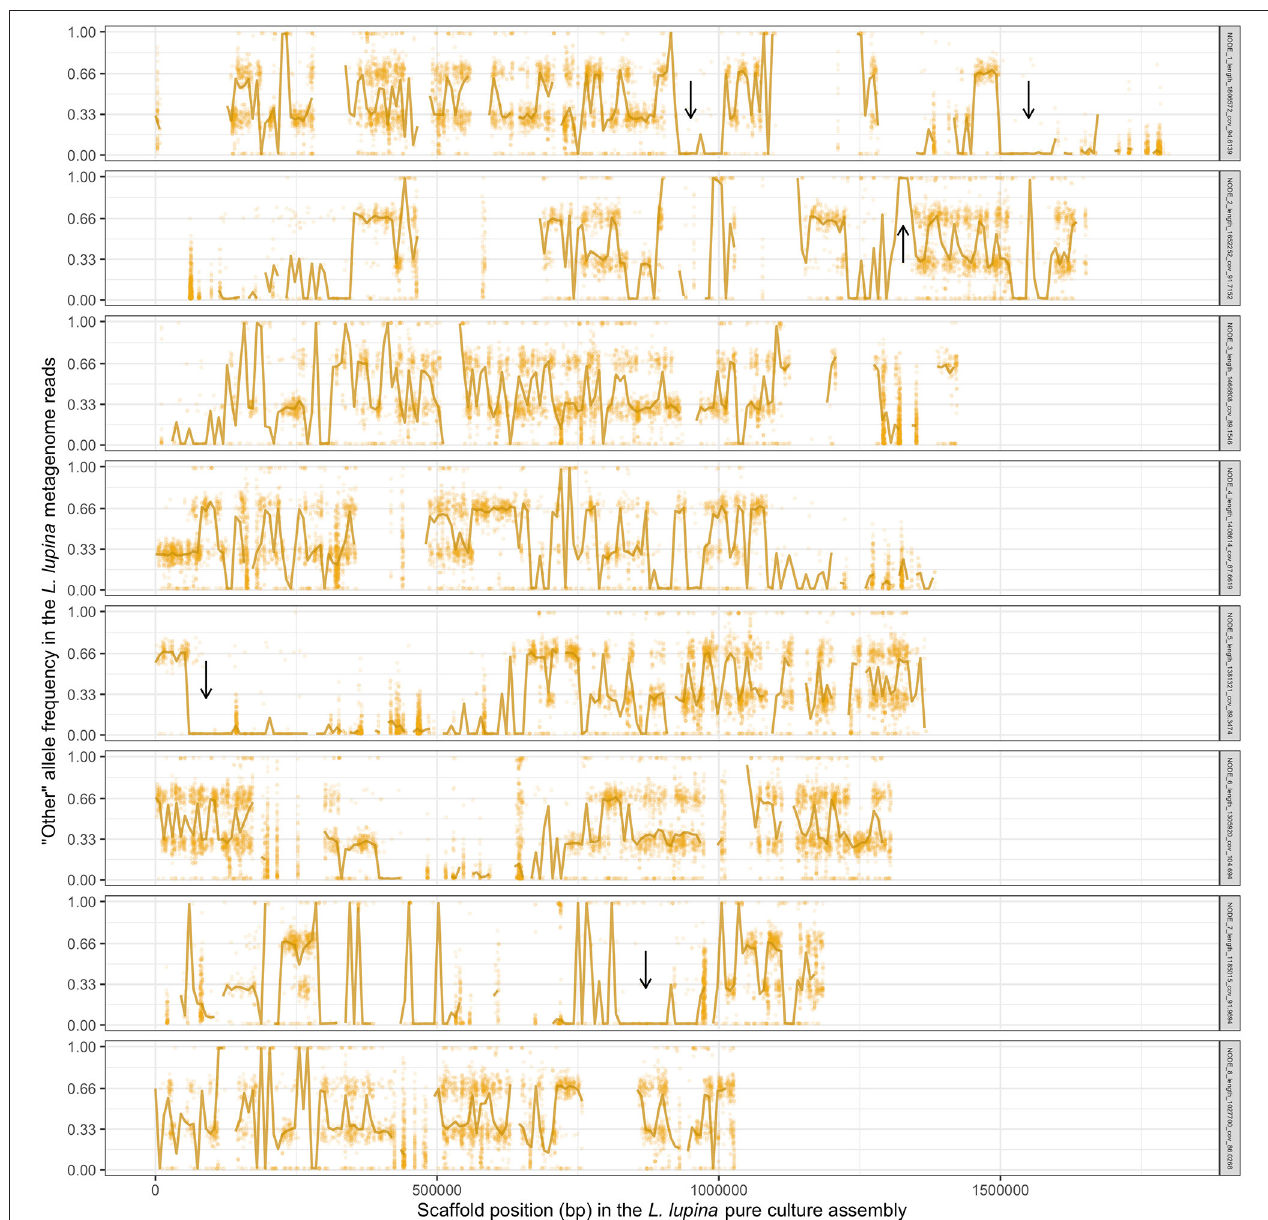
FIGURE 5 | Frequency of the “other” (alternative) allele in the reads of the L. lupina metagenome when mapped to the L. lupina pure culture assembly (only the eight largest scaffolds are shown). Golden points represent the raw allele frequency at each site, while the solid line connects the median allele frequency of non-overlapping 7.5 kb-long windows. Sites and windows overlapping with repetitive elements were discarded (missing data). Representative areas with long tracks of loss of heterozygosity (LOH) are marked with arrows.